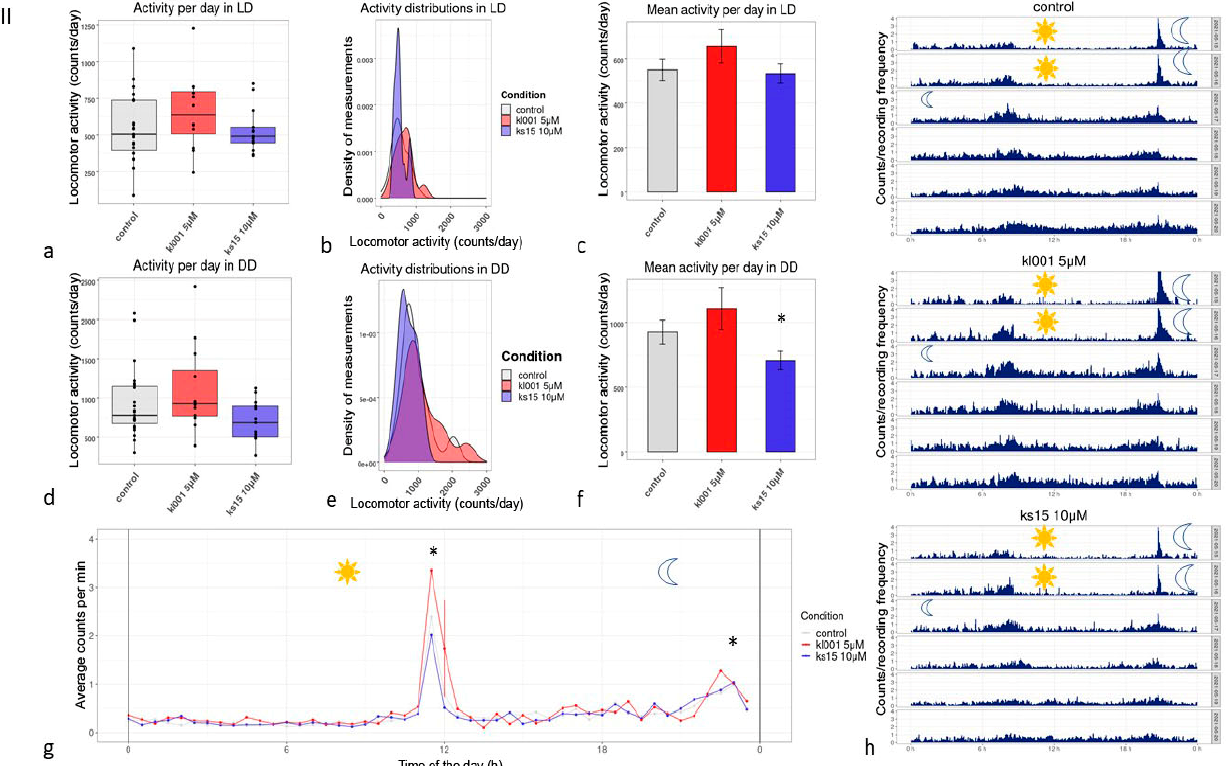
Figure 2. The locomotor activity profiles measured for CS males treated with lifespan modifying doses of KL001 и KS15 until the age of 34–41 days: ( a , d )—activity per day in LD and DD; ( b , e )—activity distributions in LD and DD; ( c , f )—mean activities in LD and DD; ( g )—profile of locomotor activity in LD, measured as an average per minute; ( h )—actogramms, presenting and comparing all the profile during six days of test, first to lines are LD, last four—DD in all three blocks; *— p < 0.0001 significant results, according to ANOVA with Tukey/Kramer procedure, p < 0.001 with Scheffe’s procedure ( c , f ); *— p < 0.05, Mann-Whitney test for control vs. KL001 comparison ( g ). In older age we observed only the effect on locomotor activity in a group which received 10 µM solution of KS15.